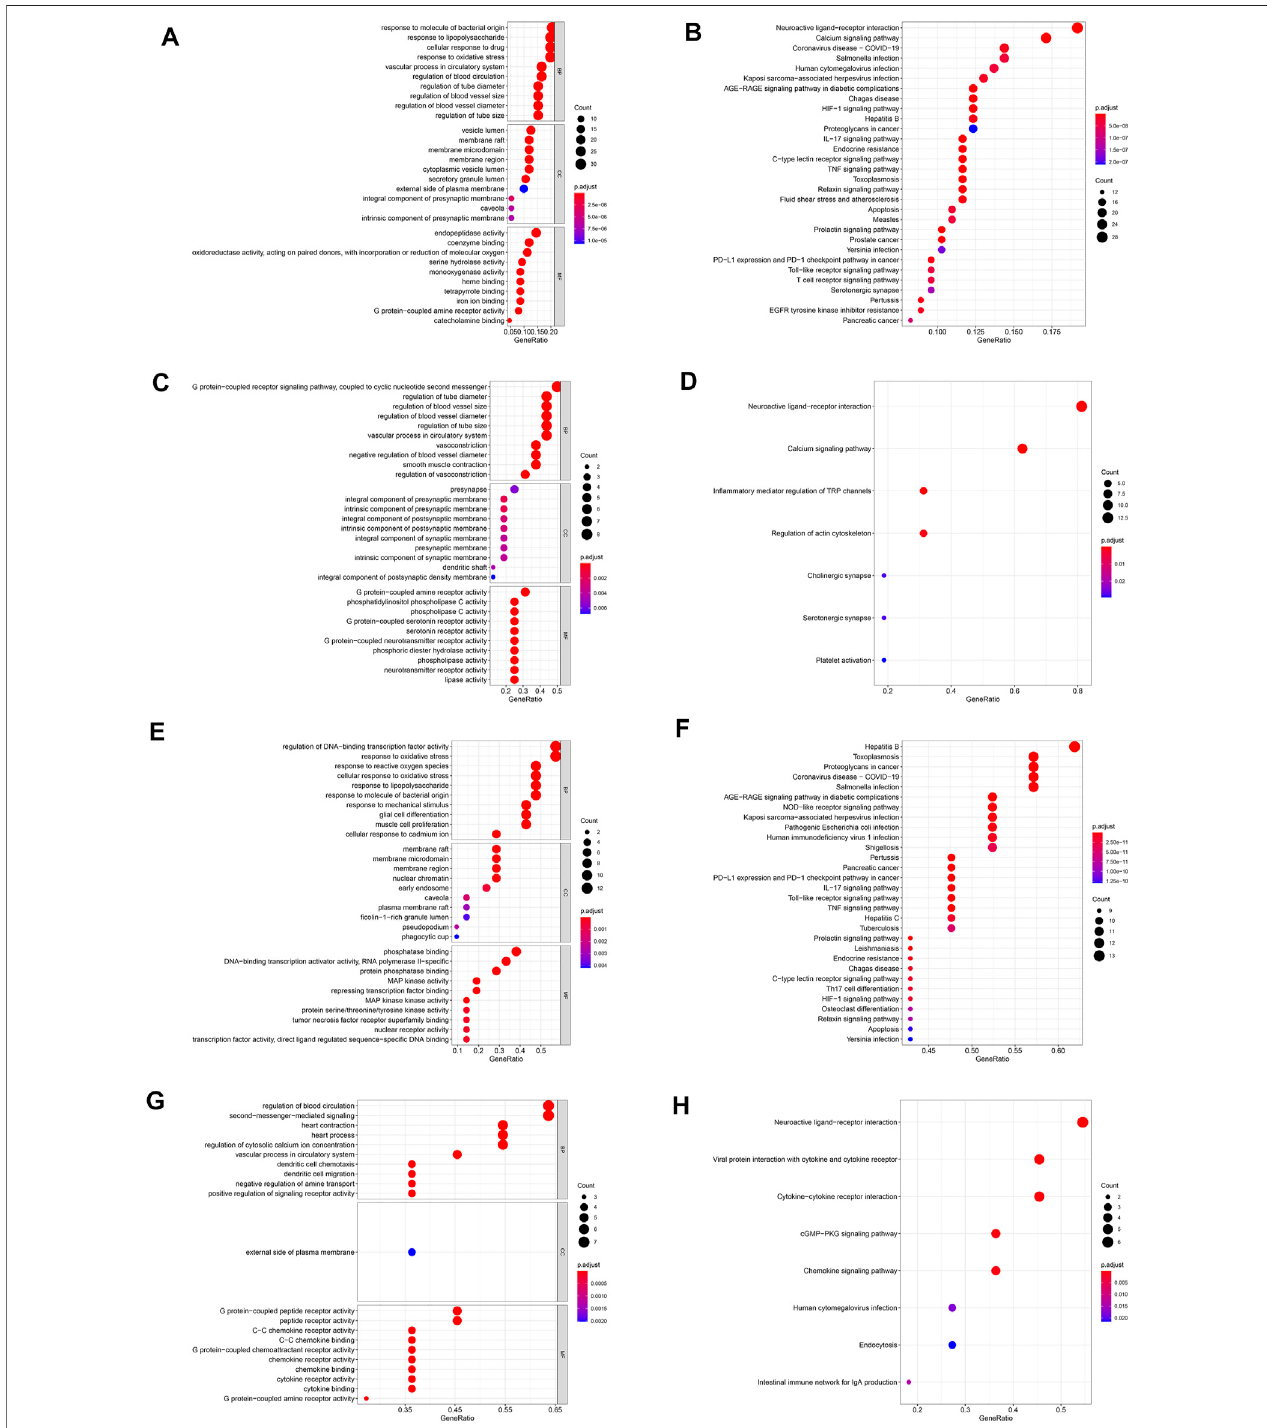
FIGURE5| GOandKEGGpathwayenrichmentanalysis. (A) Goenrichmentanalysisofprotein-proteininteractiontargets. (B) KEGGpathwayenrichmentanalysis ofprotein-proteininteractiontargets. (C) Goenrichmentanalysisofmodule1. (D) KEGGpathwayenrichmentanalysisofmodule1. (E) Goenrichmentanalysisofmodule 2. (F) KEGG pathway enrichment analysis of module 2. (G) Go enrichment analysis of module 3. (H) KEGG pathway enrichment analysis of module 3.